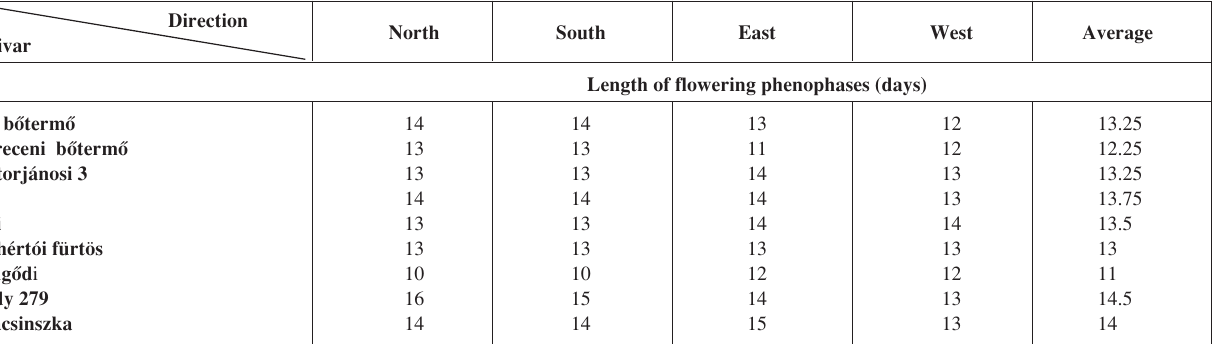
ÉvaPetriÚjfehértóifürtösCsengôdiPandy279Oblacsinszka ÉrdibôtermôDebrecenibôtermôKántorjánosiÉva